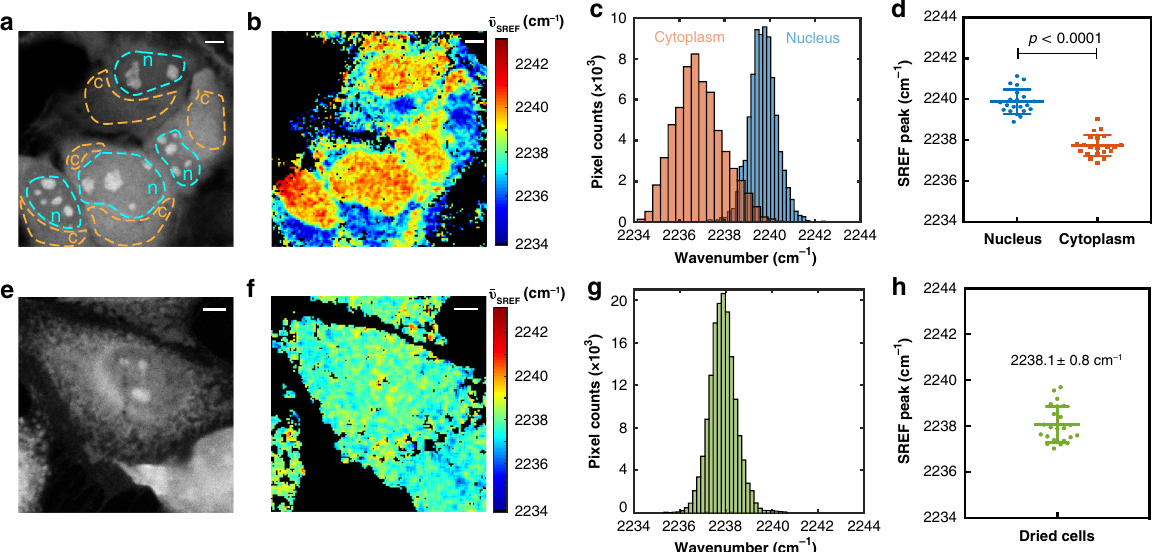
Fig. 3 Mapping water heterogeneity in live cells. a A representative intensity-based SREF image of Rh800 stained living HeLa cells (pump = 836 nm). b Heterogeneous map of nitrile peak frequency. c Nitrile peak frequency histogram of two regions (n for nucleus and c for cytoplasm, marked in c with dash line) in live HeLa cells. d Nitriles peak frequency distribution (mean ± s.d.) of nucleus (2239.9± 0.6 cm − 1 ) and cytoplasm (2237.7± 0.5 cm − 1 ) among 21 HeLa cells. p < 0.0001 for two-sided paired t -test, n = 21. e A representative SREF image (pump = 836 nm) of ethanol-dried HeLa cells stained by Rh800. f Fitted frequency map shows the heterogeneities between nucleus and cytoplasm disappear for dried cells. g Nitrile peak frequency histogram of ( f ) indicating a single-group distribution. h Nitrile peak frequency distribution of 23 dried HeLa cells (mean± s.d., 2238.1 ± 0.8 cm − 1 ). Scale bar: 5 μ m. Error bars represent standard deviations